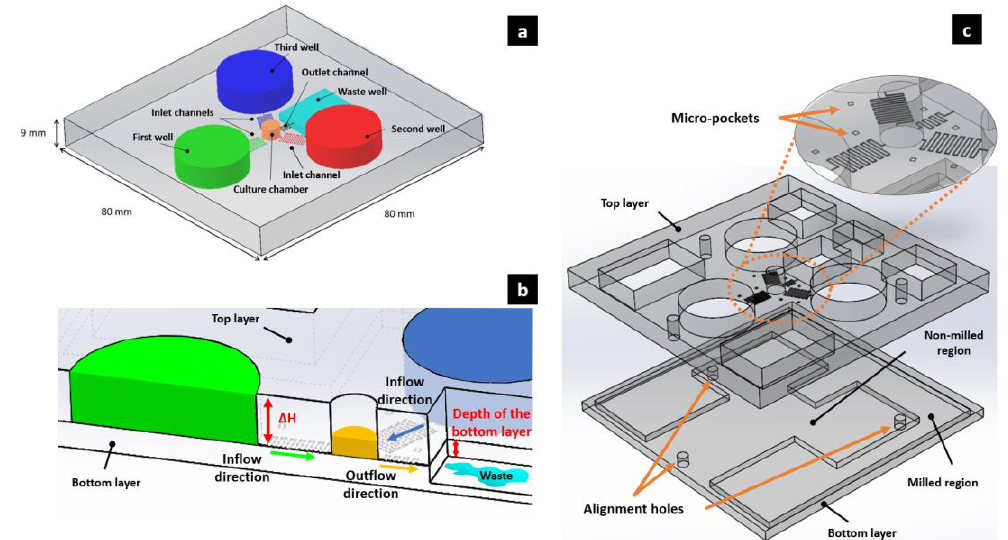
Figure 1. ( a ) A 3D schematic drawing of the assembled device. The bottom layer is not highlighted; ( b ) Section of the device. We can see the direction of the fluxes and the height ∆ H of the fluids inside the reservoirs. The depth of the waste reservoir obtained manufacturing the bottom layer is visible. ( c ) View of the top and bottom layers with a zoom-in of the microchannels network. Three alignment holes help to fix the two layers with three screws during the bonding, while micro-pockets are useful to verify the presence of tilts or errors in the machined substrate with a profilometer. The milled region of the waste reservoir is located at a deeper level than that of the other tanks, in order to ensure a maximum pressure gradient between the waste reservoir and the culture